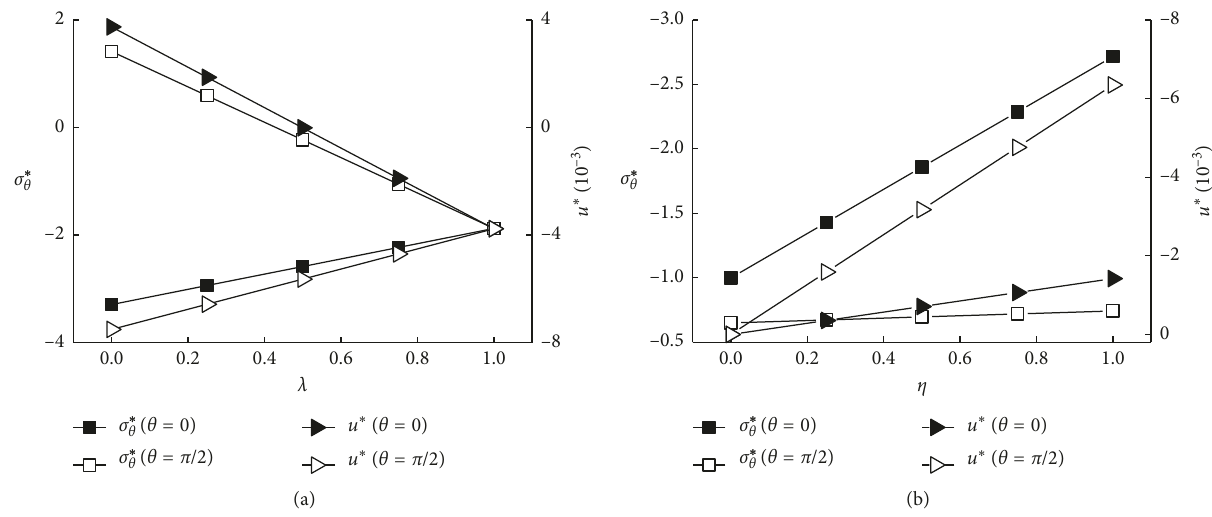
Figure 6: σ ∗ and u ∗ at the inner edge of the inhomogeneous frozen wall as a function of (a) λ and (b) η . θ